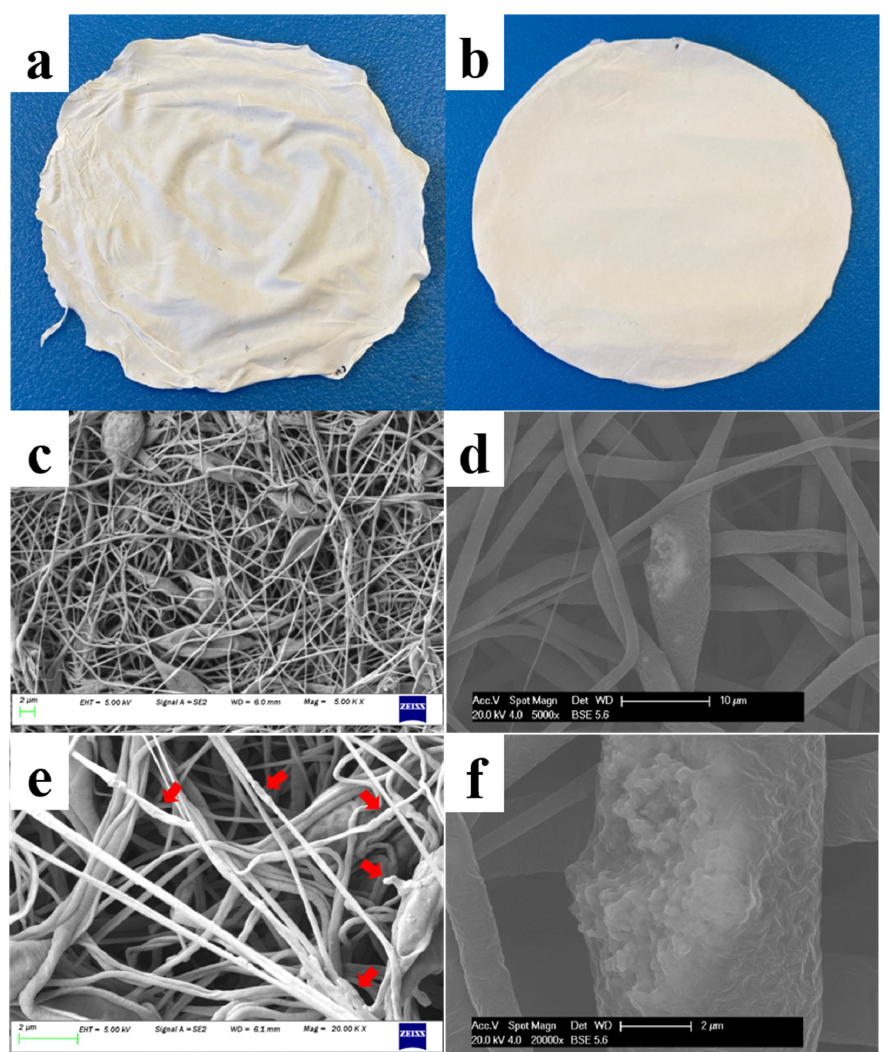
Figure 3. The macroscopic appearances of ( a ) a 5% PCL membrane spun with CaCO 3 NPs and ( b ) a 10% PCL membrane spun with CaCO 3 NPs. The SEM images of ( c ) 5% PCL nanofibers spun